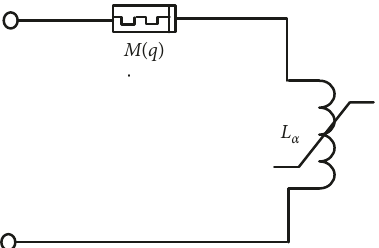
Figure 1: Equivalent circuit model of the memristor affected by the parasitic fractional